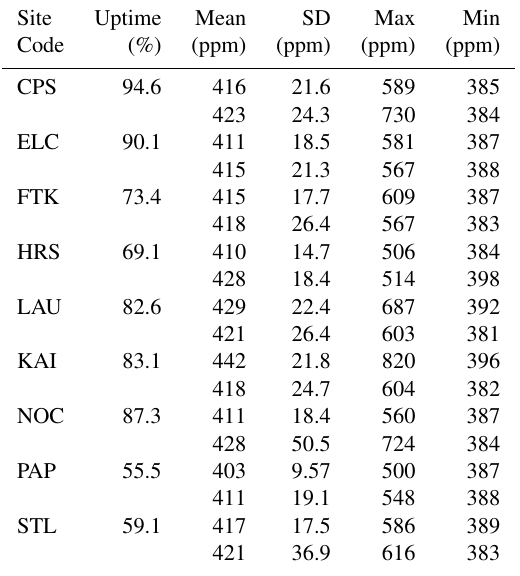
Table 2. Descriptive statistics for the drift- and bias-corrected CO 2 dry air mole fractions measured at nine representative sites dur- ing 2013. Upper row for each site gives the daytime (11:00–18:00 LT) statistics; lower row gives the nighttime (22:00–04:00 LT). The ELC node is corrected using weekly minimum LI-COR measure- ments as the regional